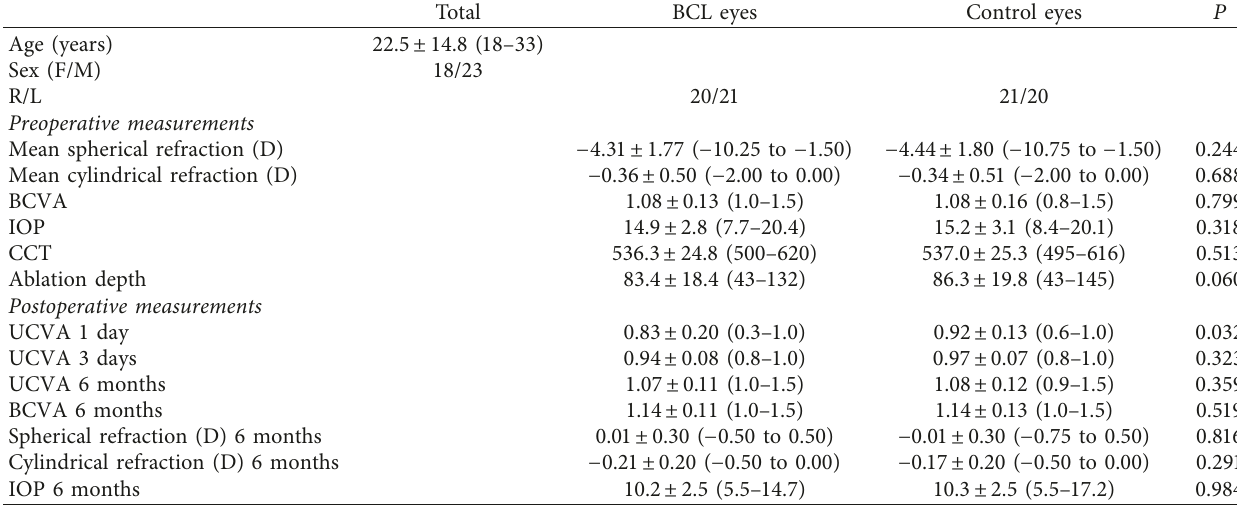
Table 1: Baseline parameters of eyes with and without BCL